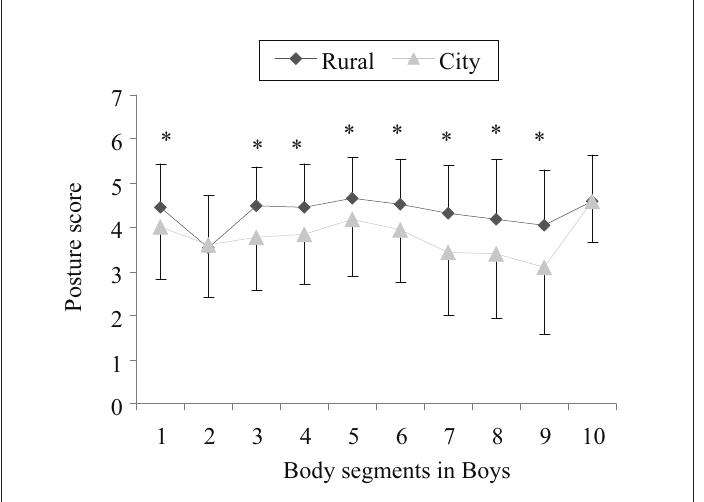
Figure 3. Alignment of different body segments in rural and city boys